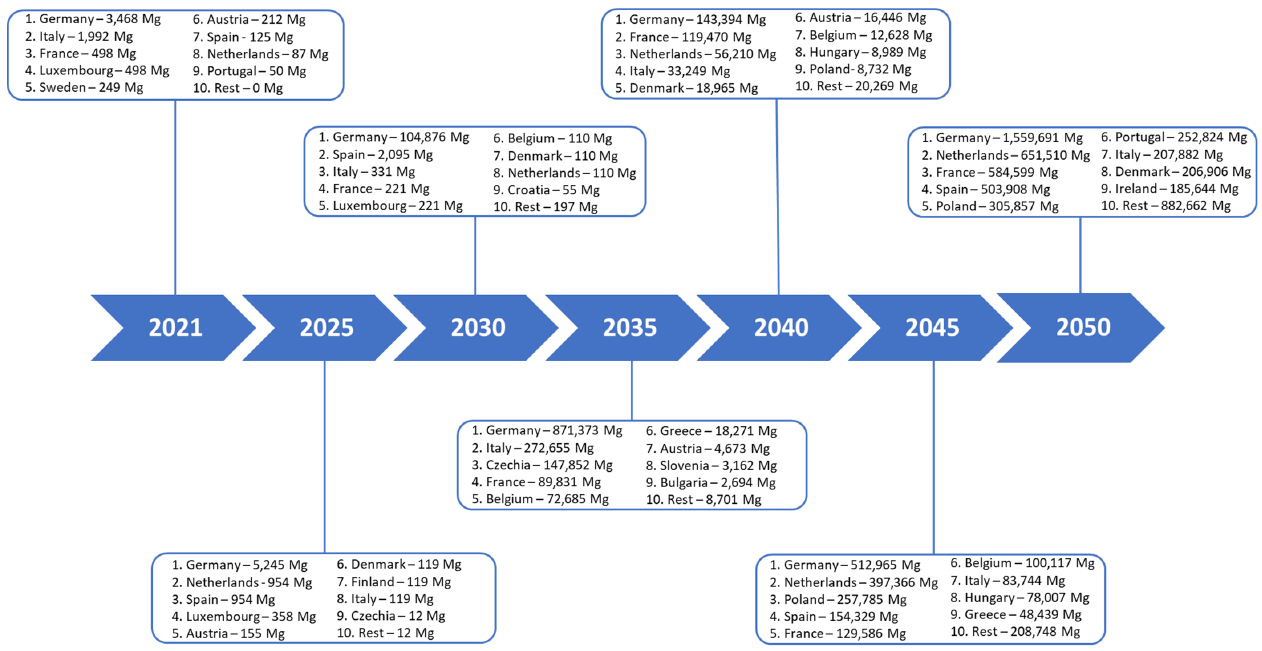
Figure 6. Annual increase in PV waste in selected years in the EU.